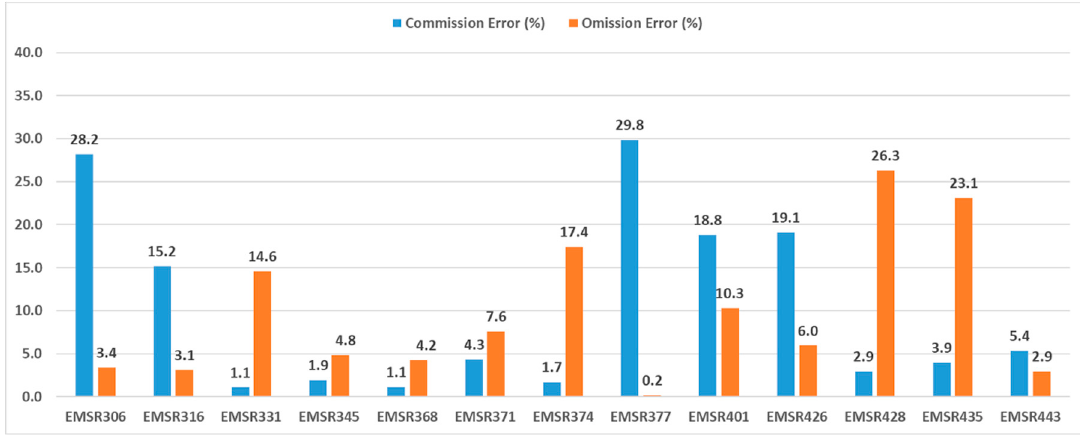
Figure 8. Disagreement between CEMS-derived and BFCA-derived BA maps represented in terms of omission and commission errors for the class of burned pixels.